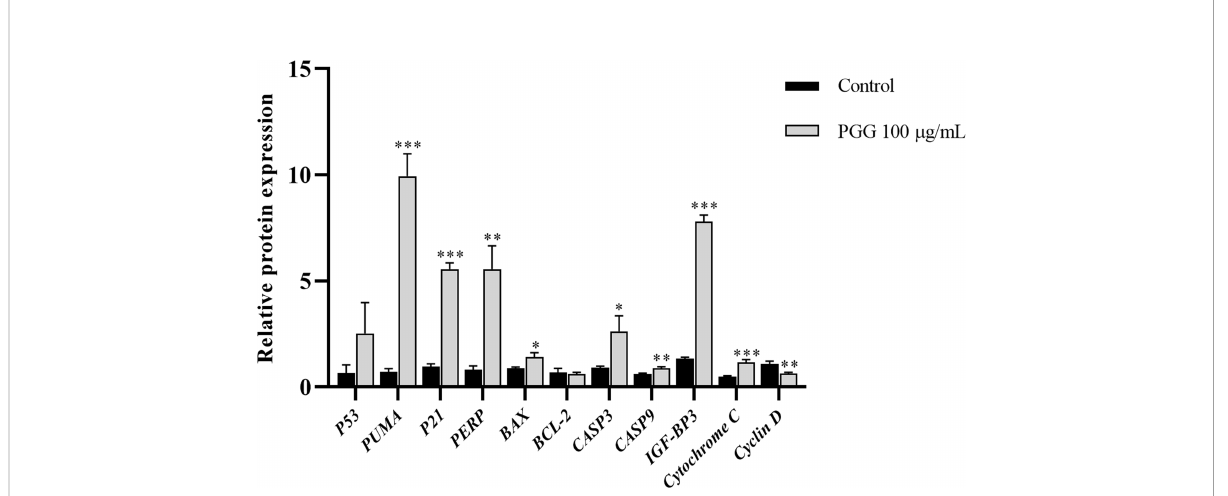
FIGURE 10 The expression levels of apoptosis-related genes in SGC7901 cells. qRT-PCR was used to determine the mRNA levels of apoptosis-related genes in SGC7901 cells. The expression levels of P21 , PERP , IGF-BP3 , PUMA , BAX , BCL-2 , CASP9 , Cyclin D , Cytochrome C , CASP3 , and P53 . Cells were treated with 100 µg/ml of 1,2,3,4,6-pentagalloyl- b -D-glucose for 24 h. * p < 0.05, ** p < 0.01, *** p < 0.001 vs. control.